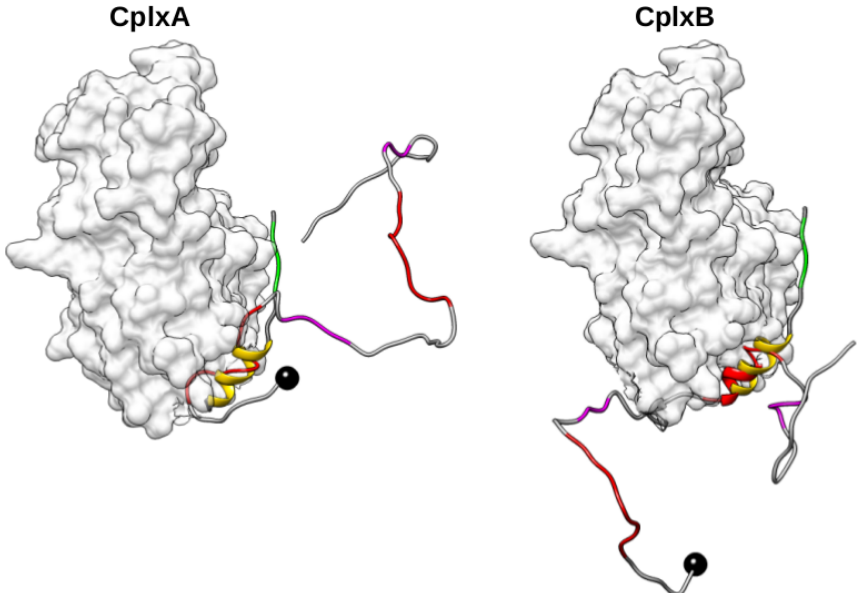
Figure 3. Side view of the two best 1:1 actin–domain V encounter complexes with N-WASP segment 9–18 ( left ) or 37–46 ( right ) located and oriented as in structure 2VCP. Black balls are N-terminal C α -atoms of domain V. Red and magenta ribbons represent its regions 9–18 or 37–46 and consensus sequences “LKKV”, respectively. As a reference, yellow and green ribbons indicate the helical and 50 LKSV 53 regions of domain VC in